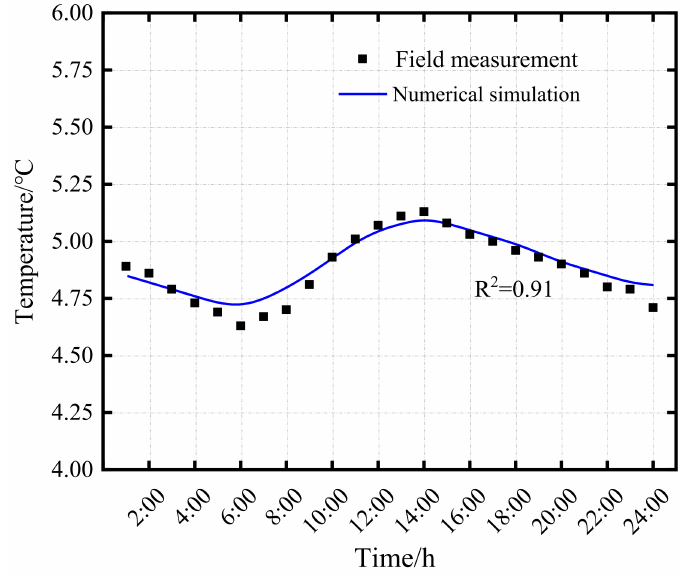
Figure 8. Comparison of measured and simulation